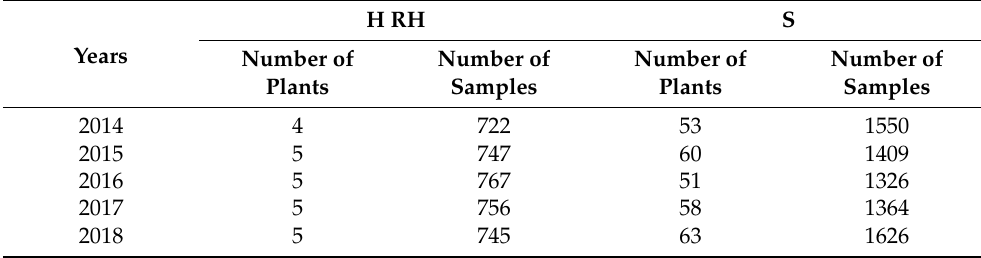
Table 1. Sampling plan of food samples and environmental swabs established for the period 2014–2018. H RH S Years Number of Number of Number of Number of Plants Samples Plants